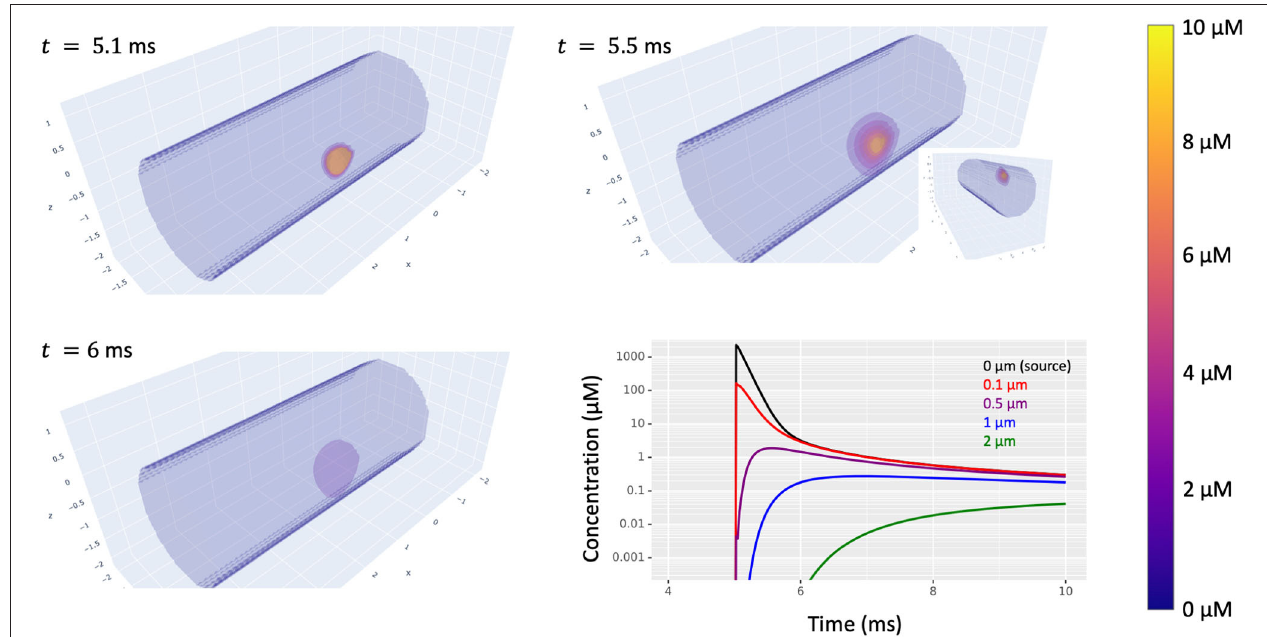
FIGURE 14 | Simulated diffusion in a cylindrical dendrite of a substance produced at (2.5,0.975,0.275) in response to synaptic input at time t images highlight translucent level sets with all concentrations above 10 µ m displayed the same. Bottom-right: concentration (on a log scale) vs. time at five distances from the source on the surface of the dendrite. Inset: a volumetric view from a different angle showing the extent of diffusion into the interior of the